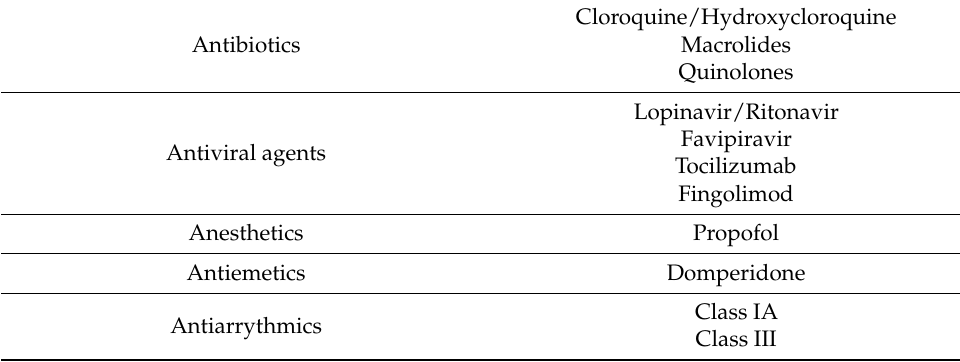
Table 6. QT prolonging drugs used in COVID-19